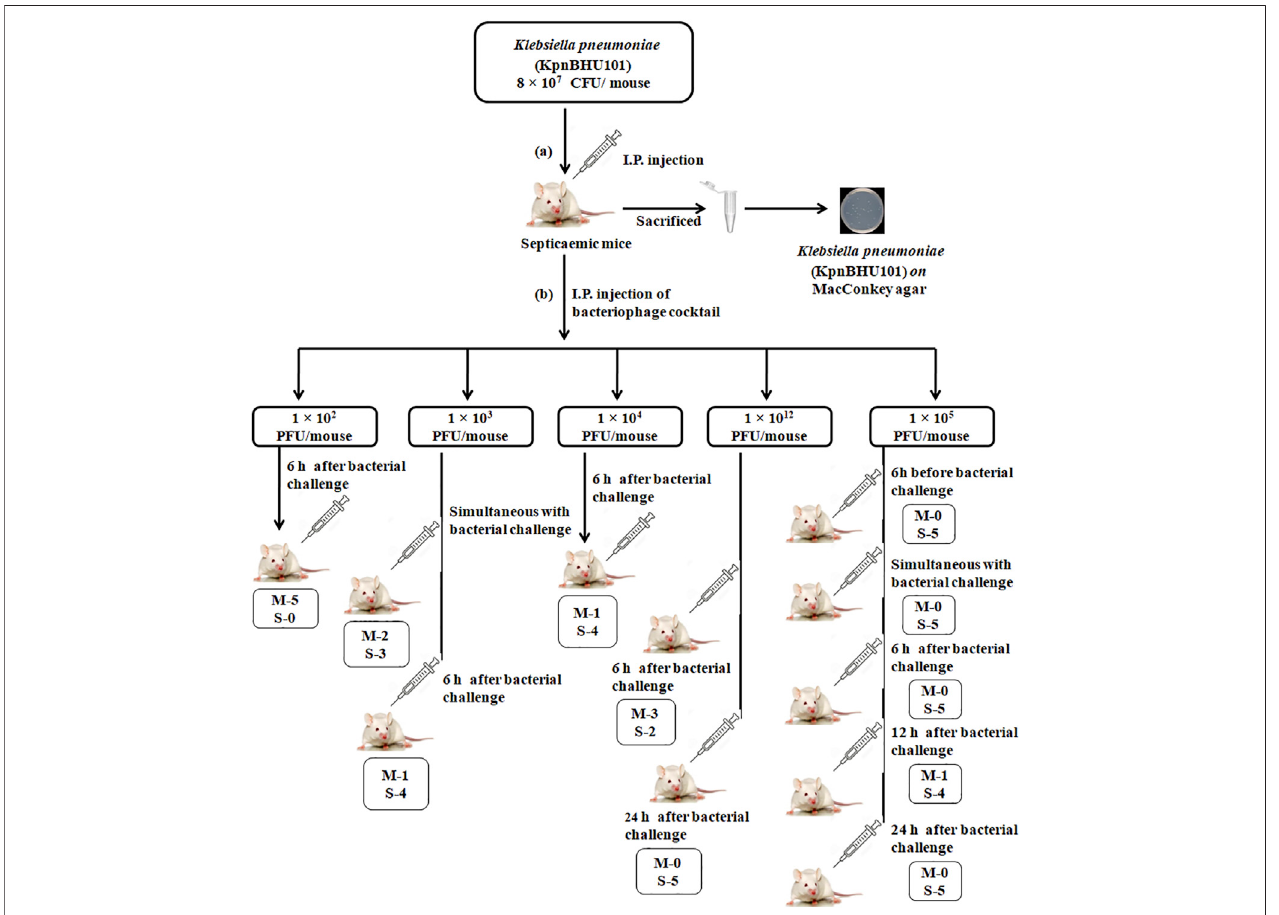
FIGURE 4 | Mouse experiment fl owchart (A) Depicts the induction of septicemia through intraperitoneal route with K. pneumoniae at the dose of 8 × 10 7 CFU/ mouseofKpnBHU101.After24 h,micewerekilled,andorganswerehomogenizedandculturedonMacConkeyplatestoseethepresenceofbacteria. (B) Outlineofthe ef fi cacy of the bacteriophage cocktail dosage with varying concentrations at a different time point after the initial bacterial challenge. Each group has 5 mice; (M) depicts the number of dead mice and (S) depicts the number of mice surviving.